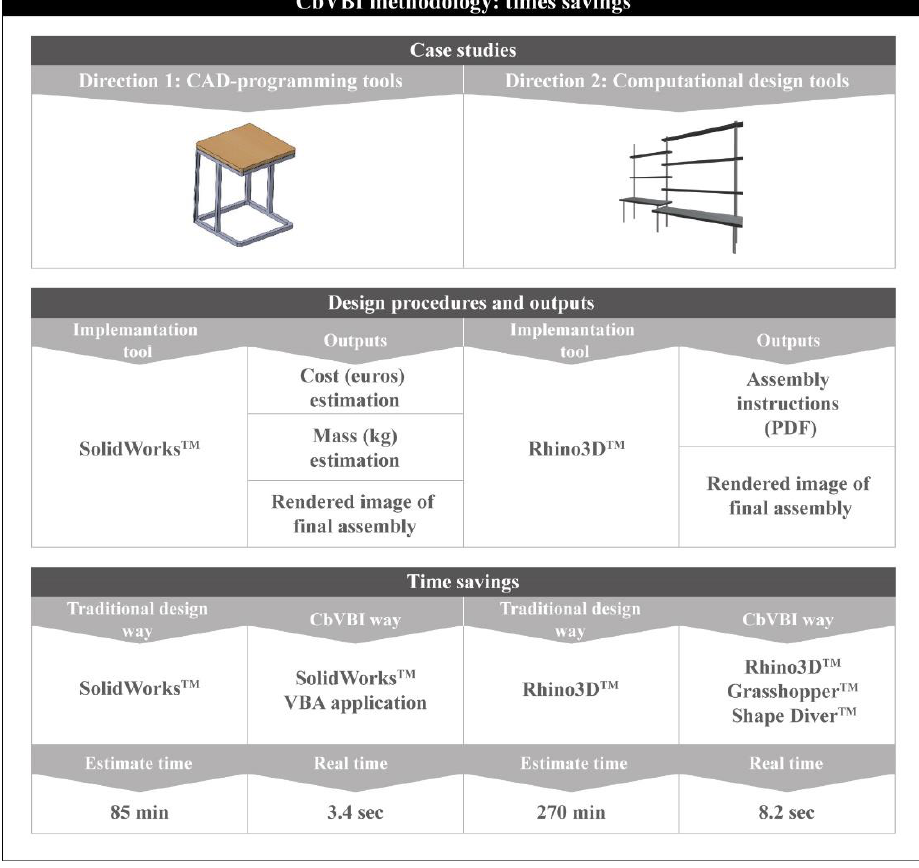
Figure 13. CbVBI time